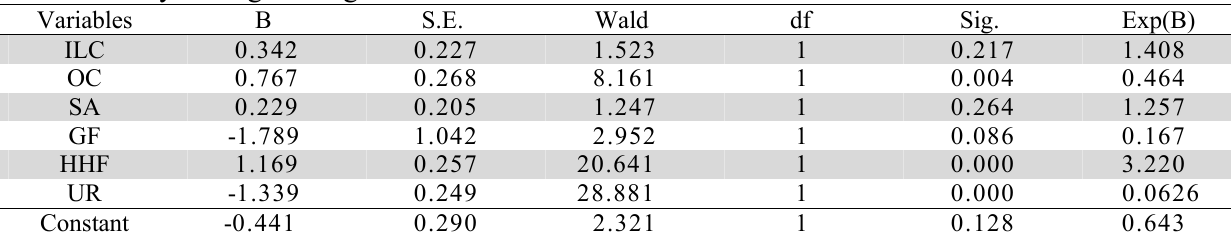
The summary of Logistic